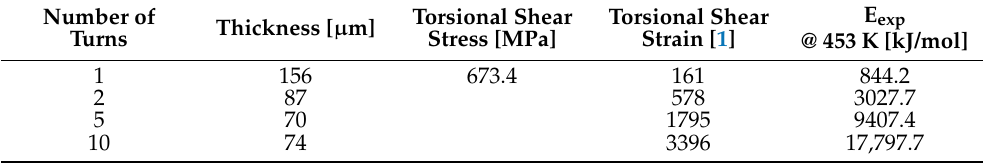
Table A1. Expended energy E exp estimated from torque measurements done during HPT, for alloy A.